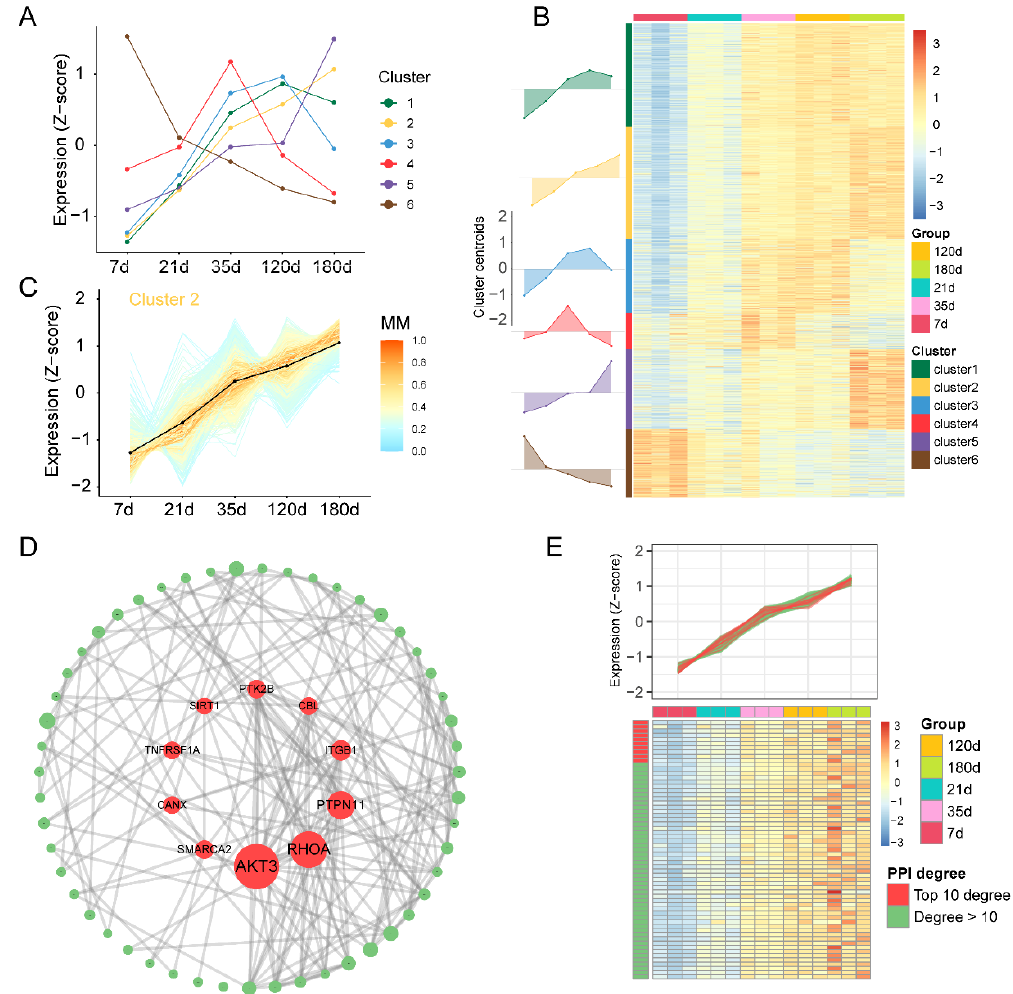
Figure 3. Global changes in gene expression across multiple time points and identification of hub genes. ( A ) Line plot displaying the expression patterns of mRNAs and cluster centroids identified